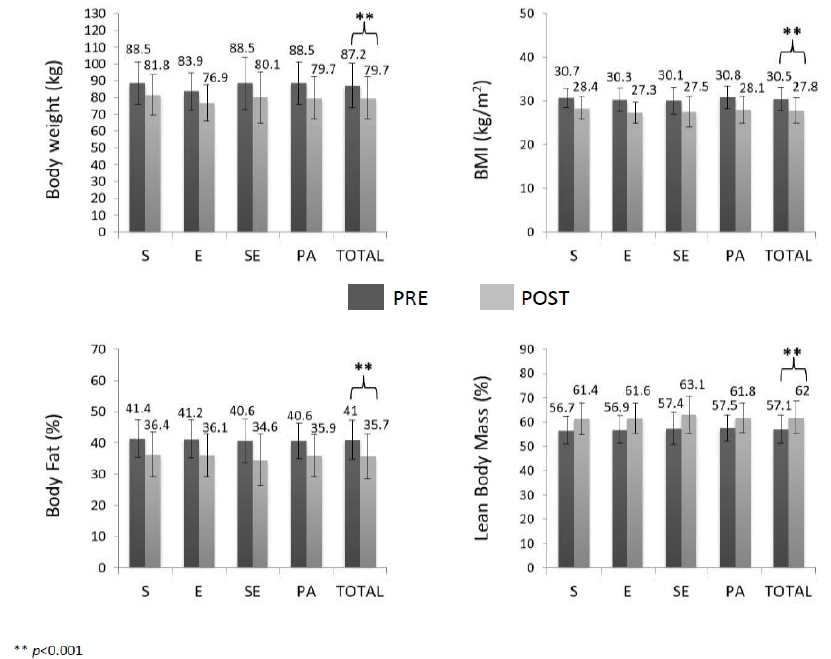
Figure 2. Anthropometric characteristics and body composition before and after the intervention. BMI: body mass index; S: strength training group; E: endurance training group; SE: combined strength plus endurance training group; PA: physical activity recommendations group.